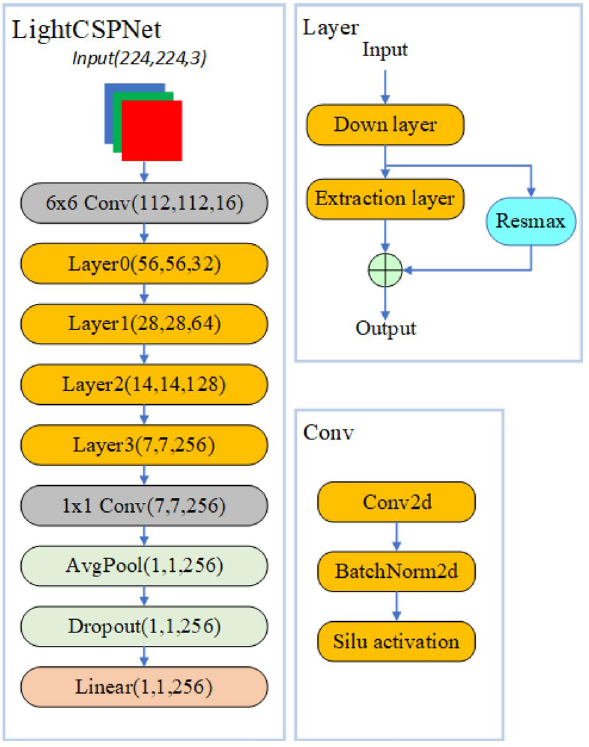
Fig. 8 The structure of LightCSPNet